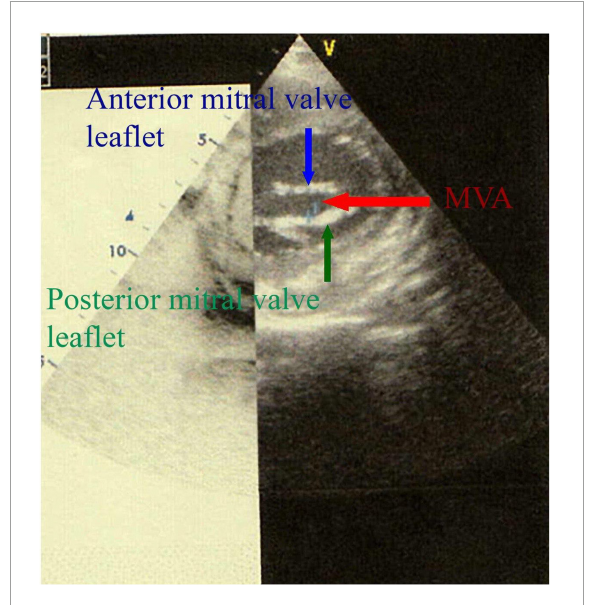
FIGURE2 Two-dimensional (2D) transthoracic echocardiography in parasternal short-axis view shows the MVA measurement by